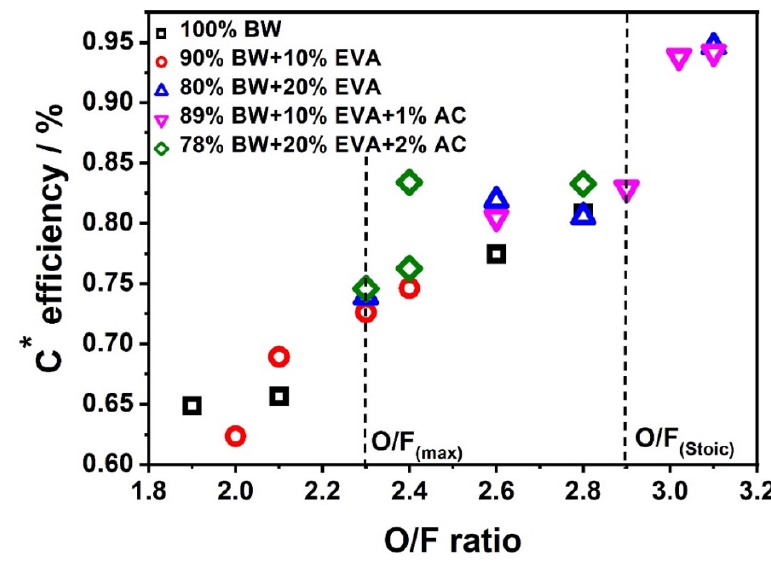
Figure 11. Combustion efficiency variation vs. O/F ratio for prepared fuels.